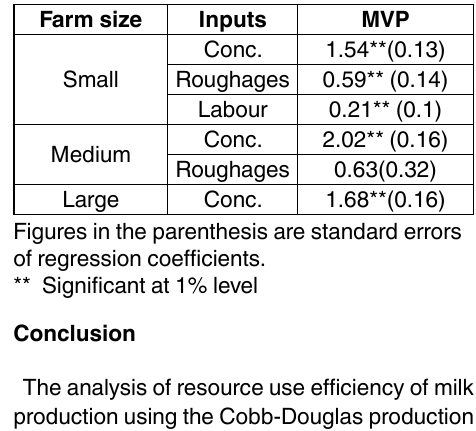
Table 2. Marginal value products of various inputs under different farm